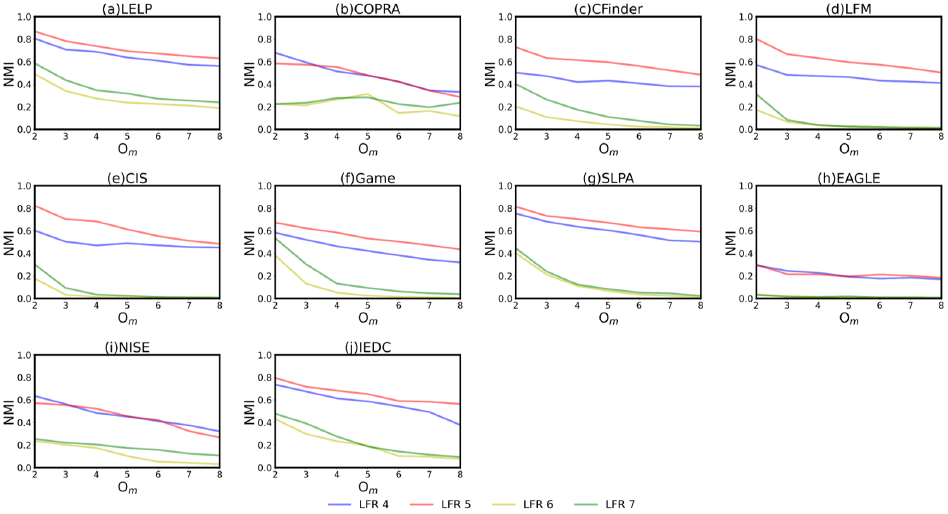
Figure 3. Sub figure ( a – j ) represent the NMI of different algorithms in the LFR 4 to LFR 7, where there are different overlapping nodes O n and community